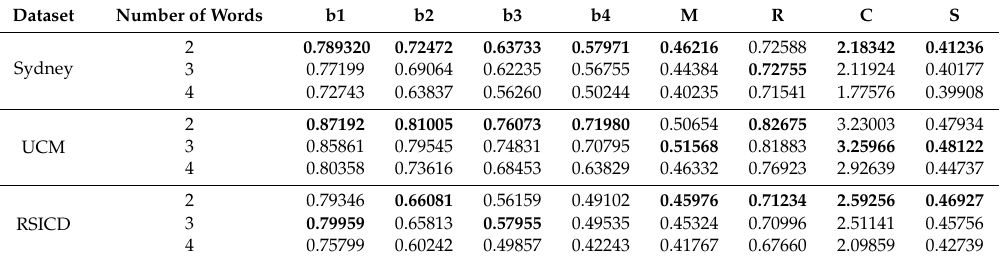
Table 7. Performance of our model under di ff erent numbers of words. The bold value is the highest